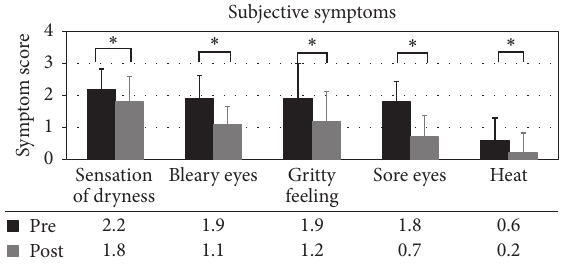
Figure 2: Subjective symptom scores for patients with meibomian gland dysfunction.